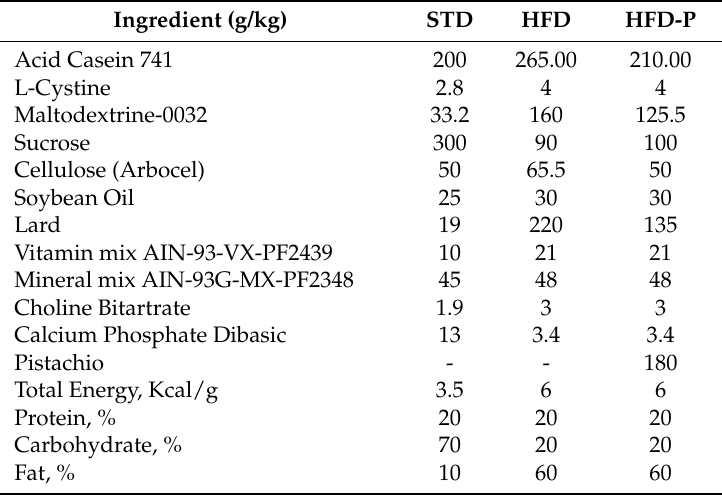
Table 1. Composition and energy densities of STD, HFD, and HFD-P.